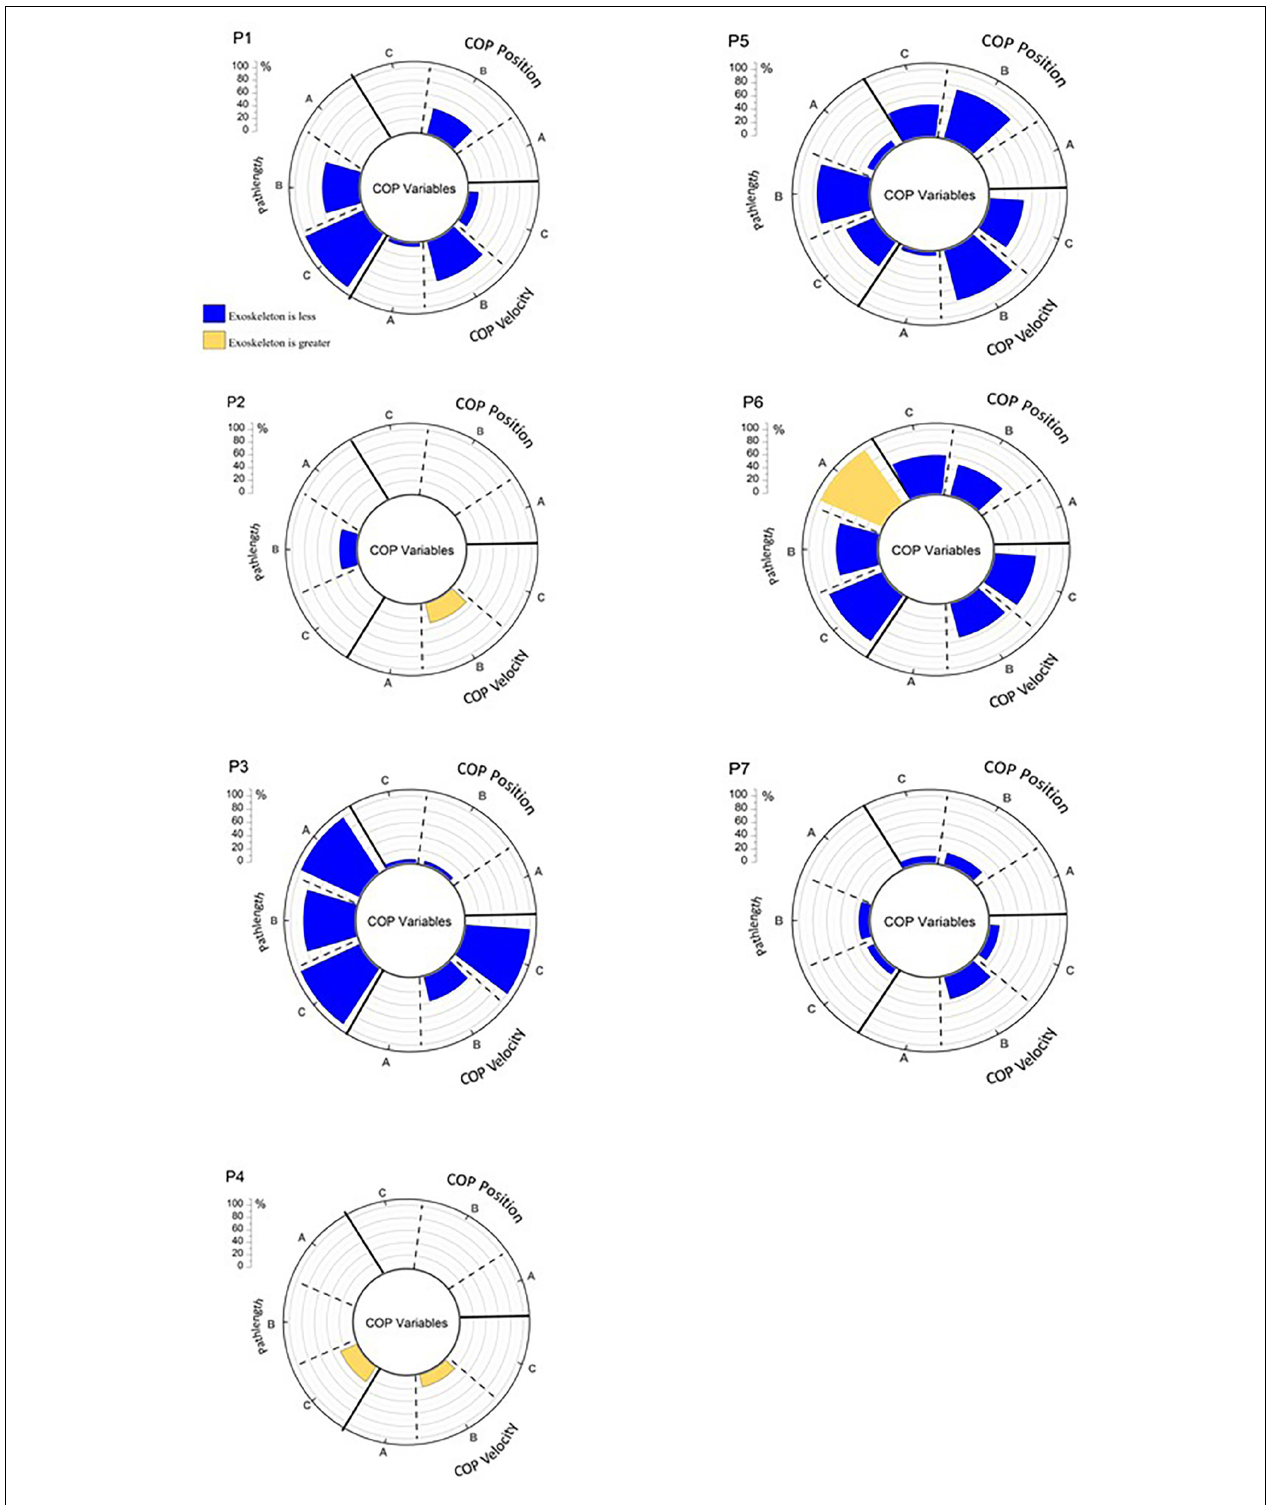
FIGURE 4 | The percentage of significant SPM testing t-values for each analysis epoch for COP by participant. A = Baseline, B = Response, C = Recovery, P = participant number. Values in blue represent that the value obtained while wearing the H2 is less than when obtained while not wearing the H2. Values in gold, represent the opposite direction of change. If there were no significant difference between wearing and not wearing the H2 there is no data represented on the chart for a given variable and epoch.